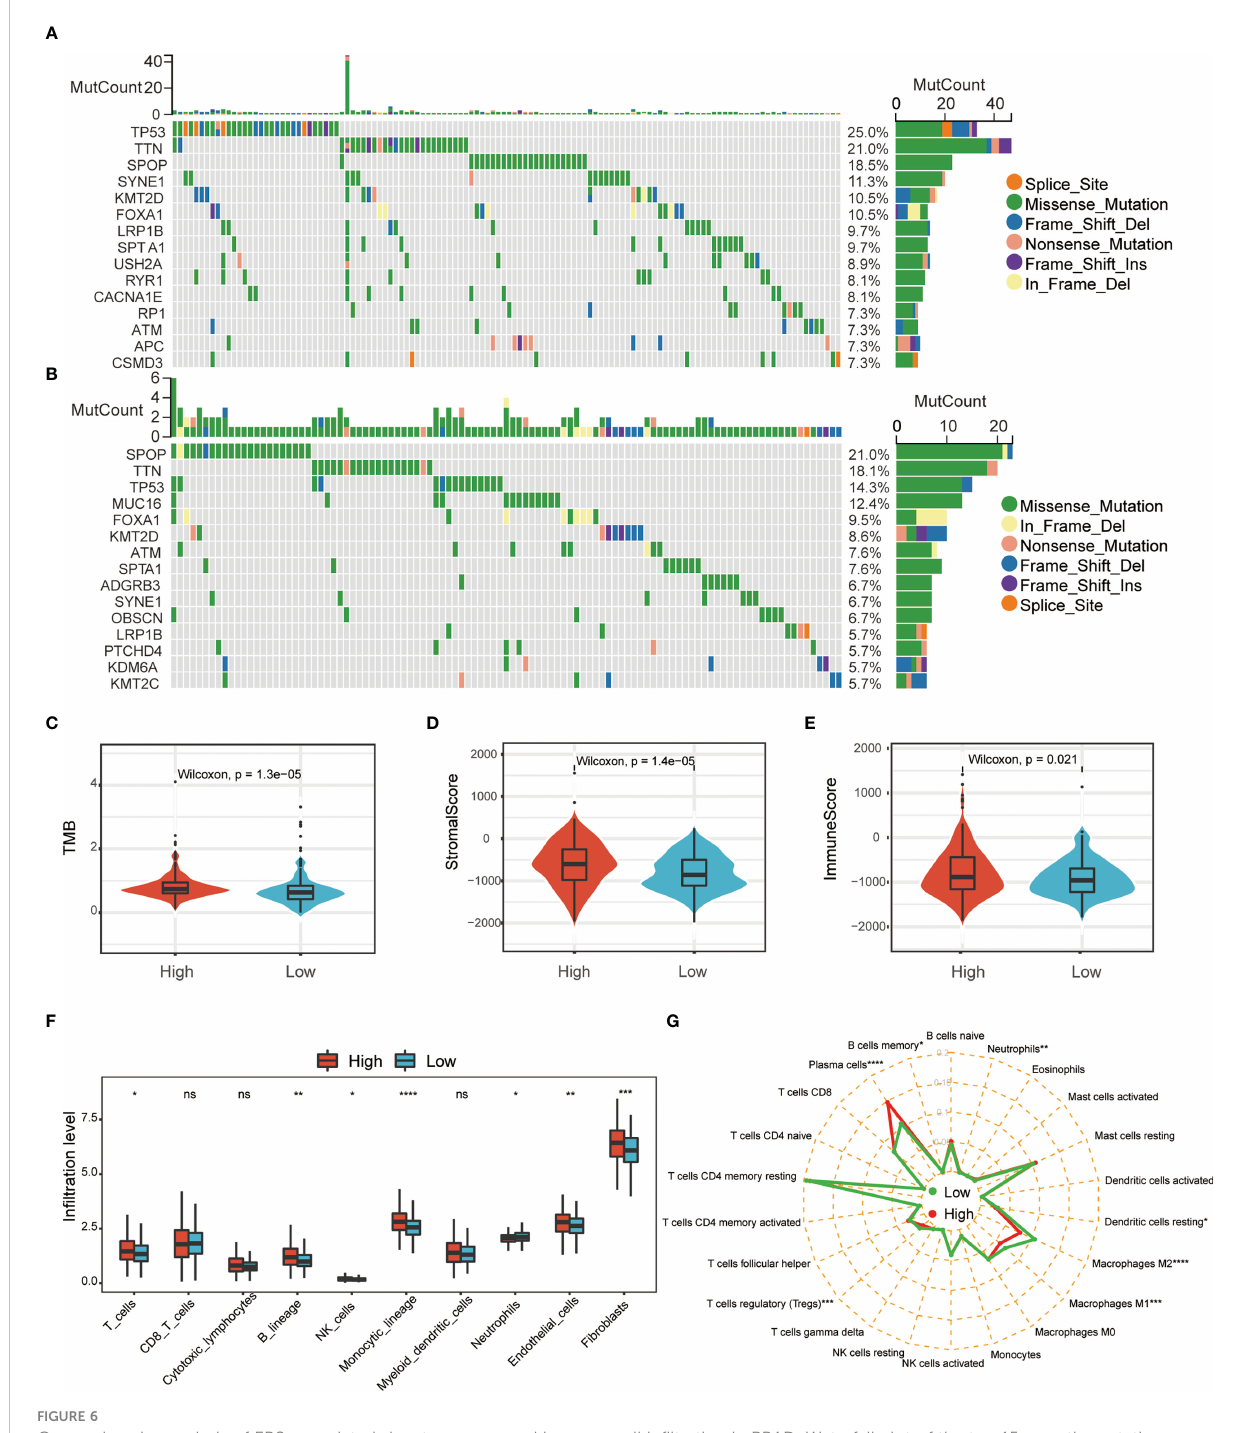
FIGURE 6 Comprehensive analysis of ERS-associated signature score and immune cell in fi ltration in PRAD. Waterfall plot of the top 15 somatic mutation signatures for groups with high (A) and low (B) ERS risk scores. (C) Relationships between ERS risk score and tumor mutational burden (TMB). Correlations between ERS risk score and both stromal (D) and immune scores (E) . MCPcounter (F) and CIBERSORT (G) were used to analyze the degree of immune cell in fi ltration in the two groups (ns, not signi fi cant; * p < 0.05; ** p < 0.01; *** p < 0.001; **** p <